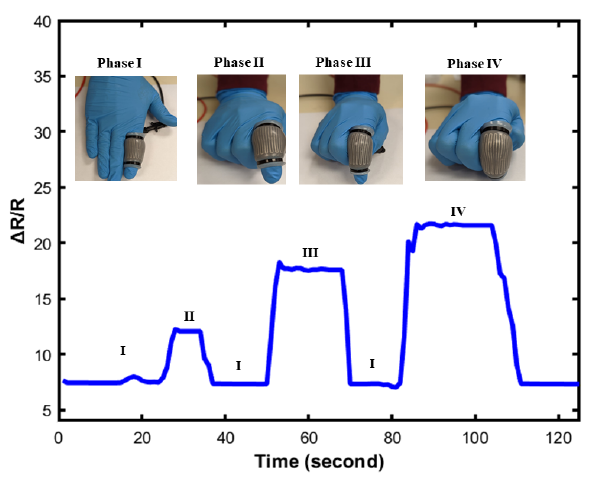
Figure 13. Performance test of the soft sensor using finger positioning. Table 3. Fabrication and printing methodology of the